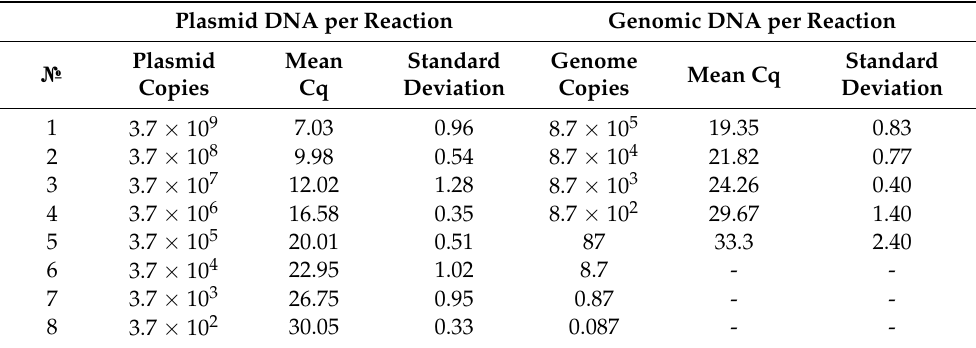
Table 2. Mean C q values for qPCR carried out on serial dilutions of genomic DNA of the P. atrosepticum SCRI1043 and corresponding plasmid.